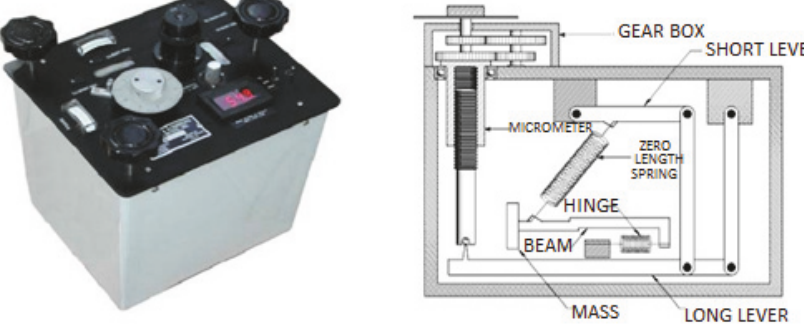
Figure 3: Lacoste and Romberg G/D gravity meters (Micro-g Lacoste,